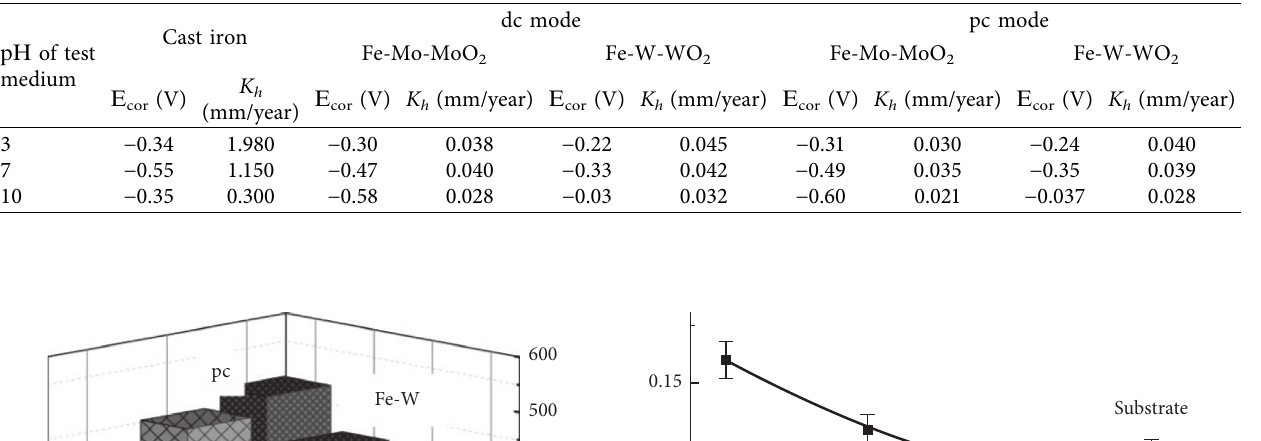
2 and Fe-Mo-MoO 2 coatings deposited by different modes.